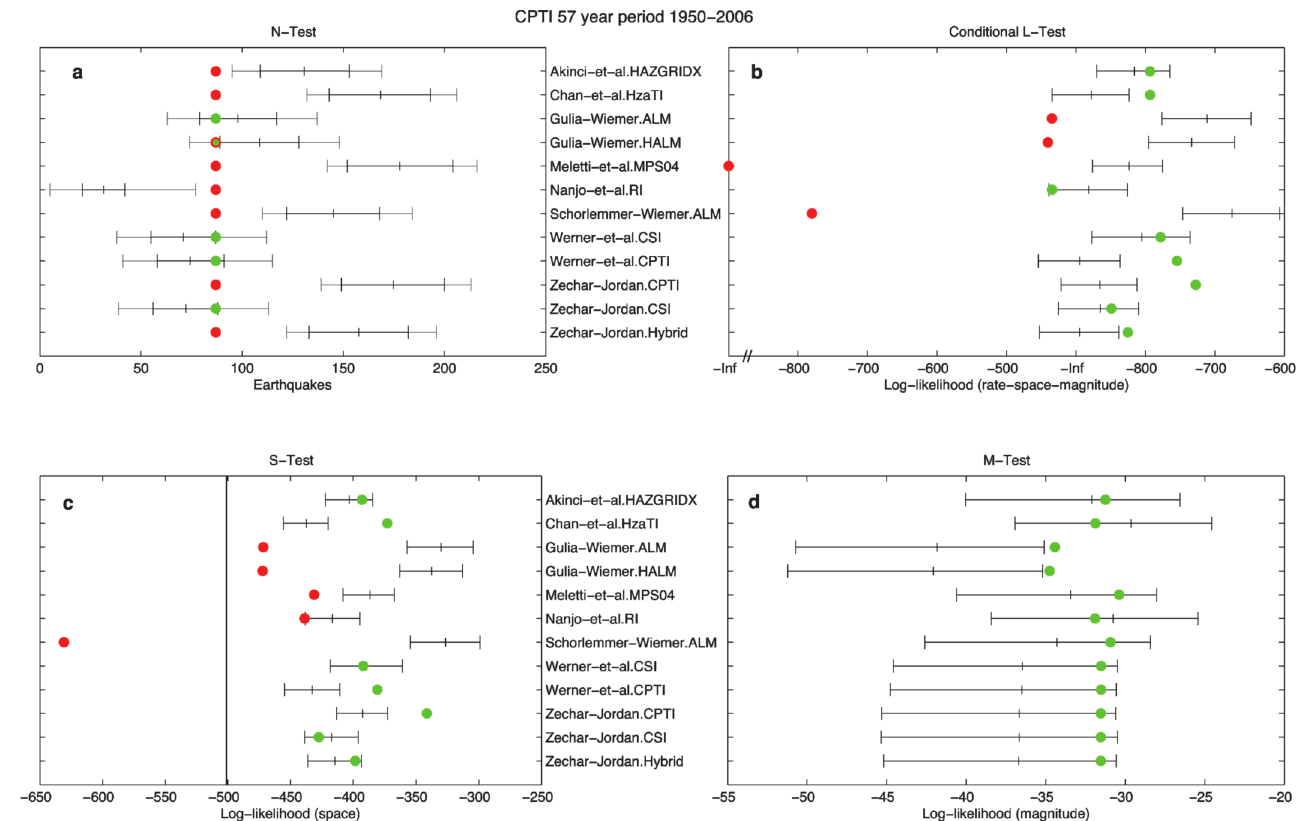
Figure 6. Results of the (a) N-Test, (b) conditional L-Test, (c) S-Test and (d) M-Test of the scaled 10-year time-independent forecasts using the 57-year target period from 1950 to 2006 of the data from the CPTI. Symbols and bars as given in the legend to Figure